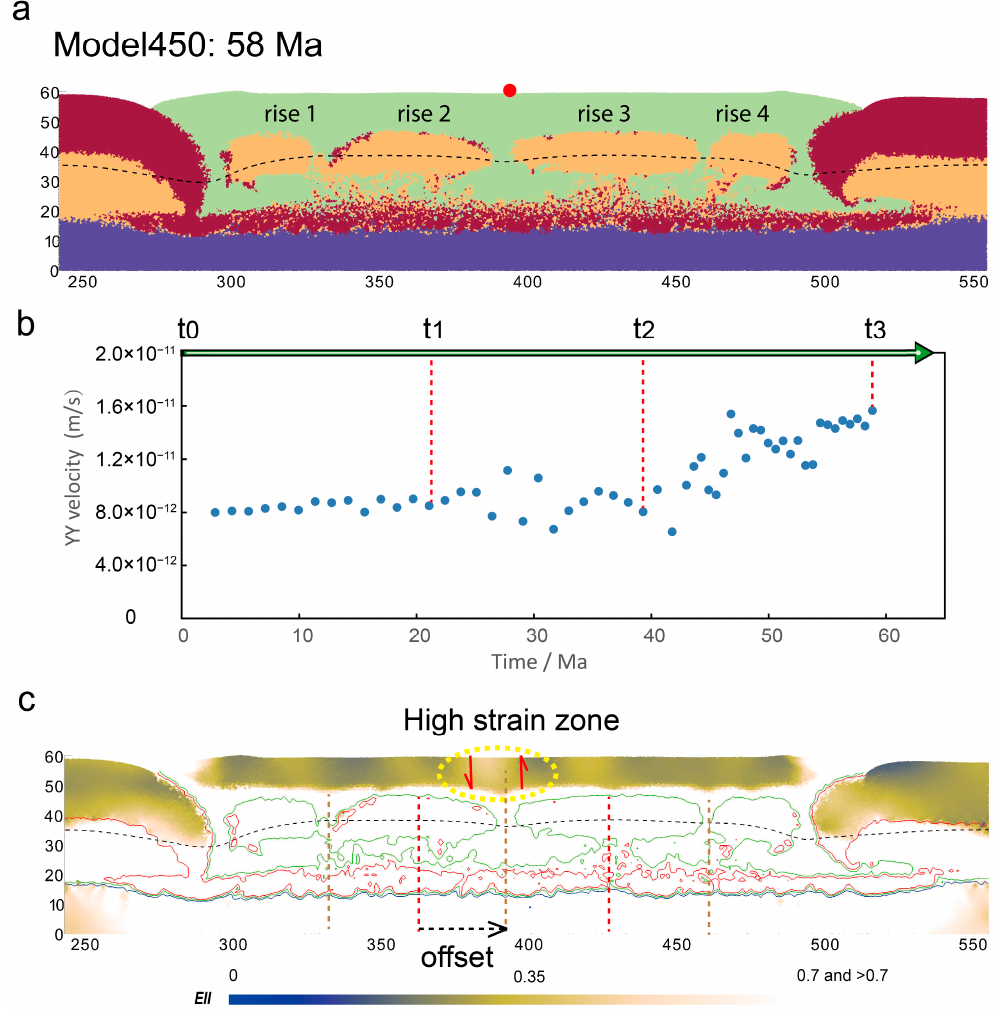
Figure 14. ( a ) Numerical results of Model450 (see detailed info in Figure 12). We shortly name the diapirs as rise 1, rise 2, rise 3 and rise 4 from left to right sides for the purposes of the discussion. The solidus temperature of the lower crust is marked by black dotted line. ( b ) The impact of the lower crust exhumation on the process of uplift. (The position used for plotting uplift is indicated by red point in Figure 14a). ( c ) The accumulation ( EII ) of the second invariant of the strain rate is employed to identify fast/slow shear strain rate over time (58 Ma) in the upper crust (about 10–20 km thick). Solid color lines represent the boundaries of different materials/states. There is an offset of 30–50 km between diapir axis (in the middle crust) and high strain zones in the upper crust. The high strain zones would favor the emplacement of dome-like granitoid bodies.